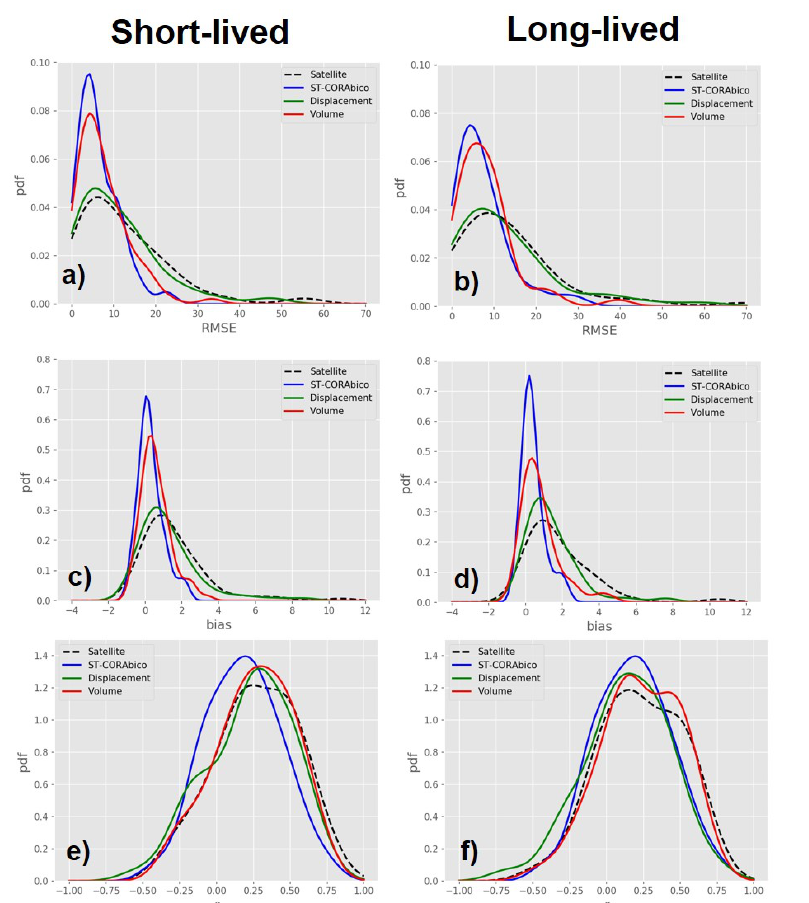
Figure 8. Satellite and bias corrected error distribution for short and long-lived events during monsoon seasons 2014–2017: ( a , b ) RMSE; ( c , d ) bias; and, ( e , f ) correlation coefficient.